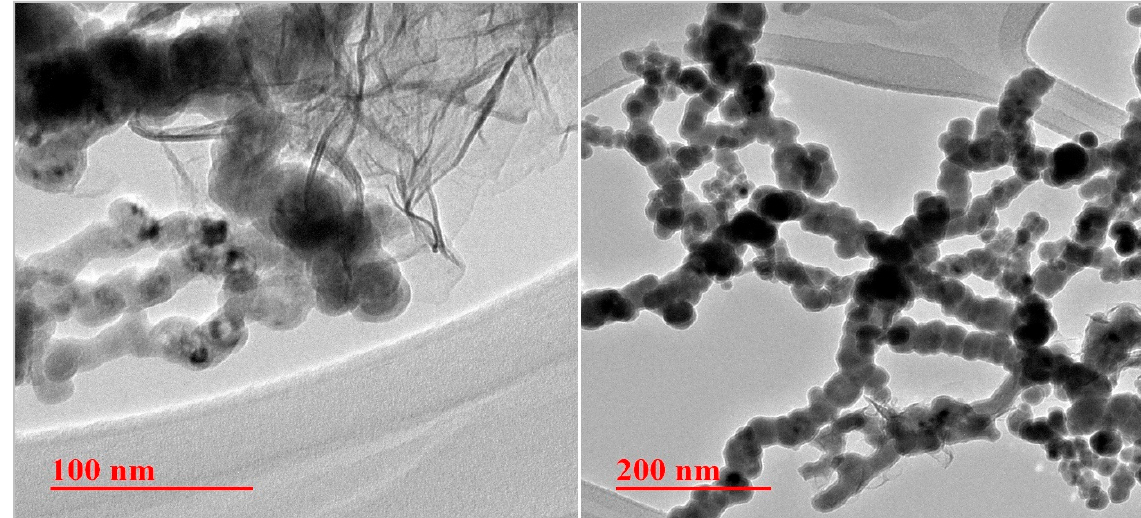
Figure 4. TEM micrographs of fresh nZVI at 100 and 200 nm scales.